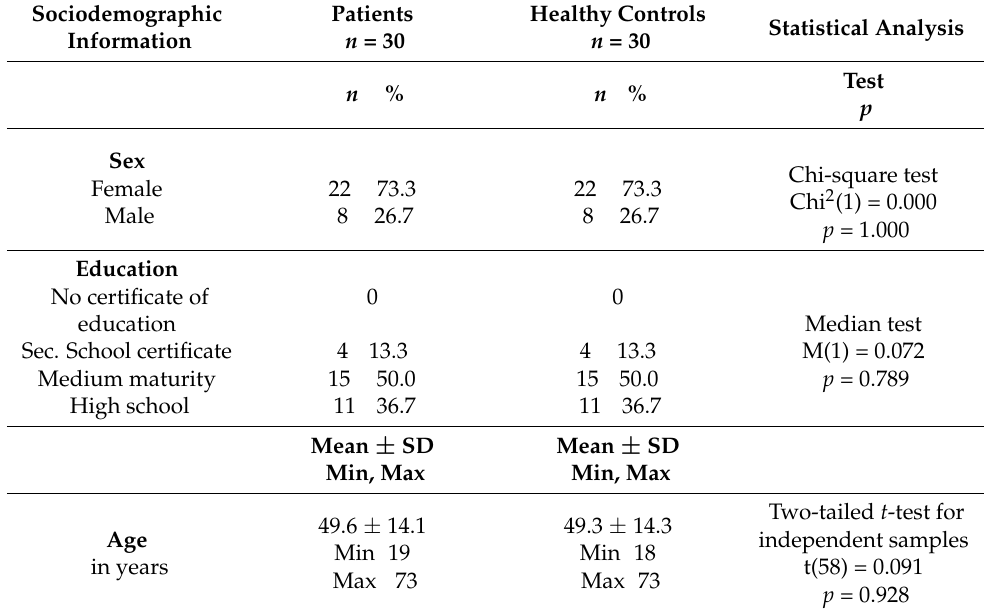
Table A1. Sociodemographic information about sex, age, and education of participants.